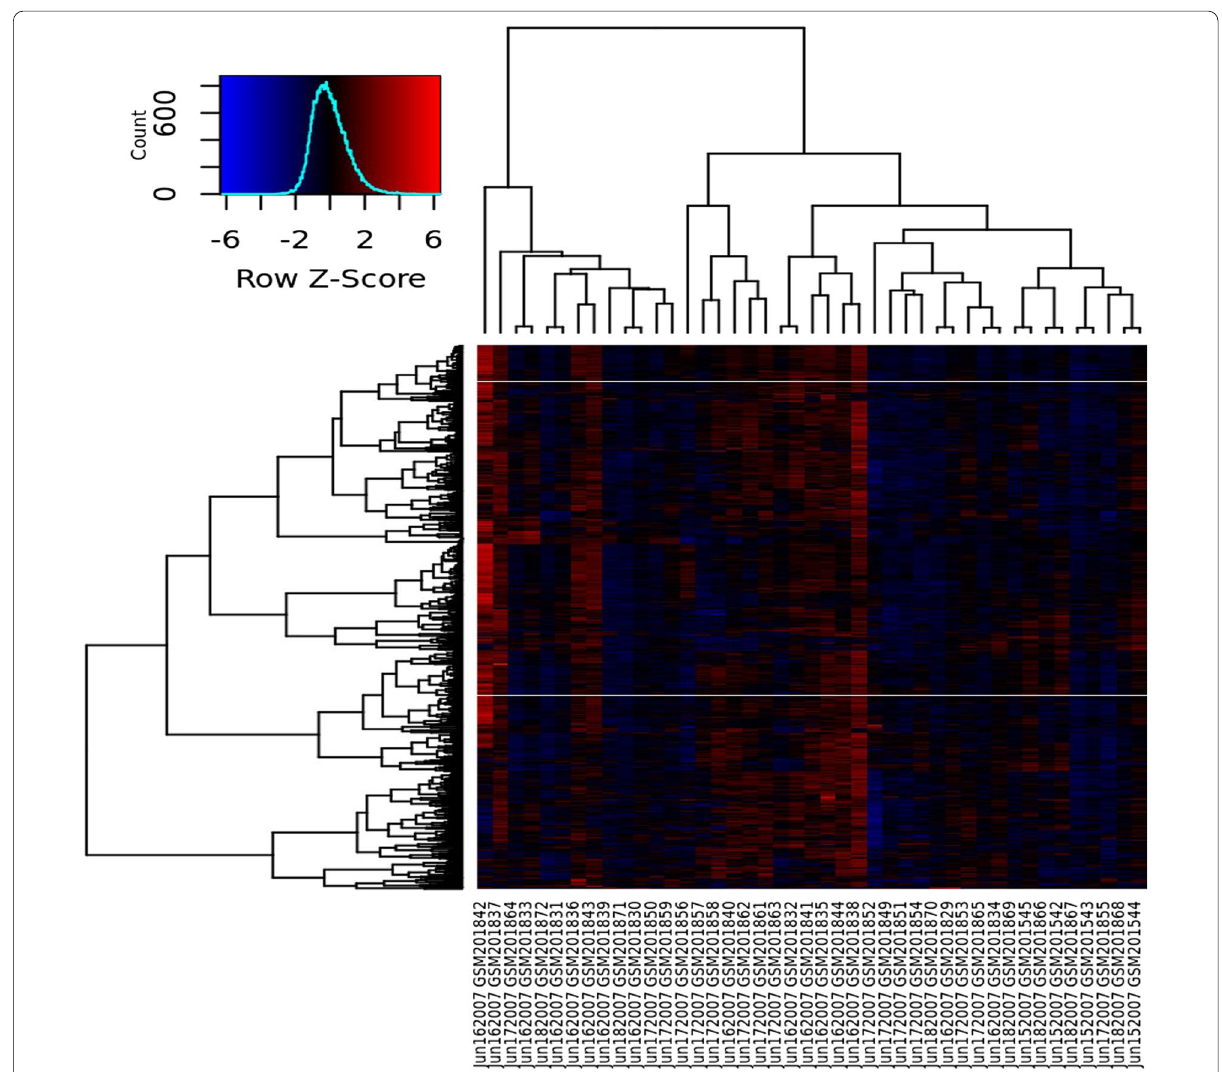
Fig. 2 Heatmap plot displayed in a grid where each row represents a gene and each column represents a sample considered in differentially expression of genes detected in comparison of control and case samples of PCOS women using BART-bioinformatics array research